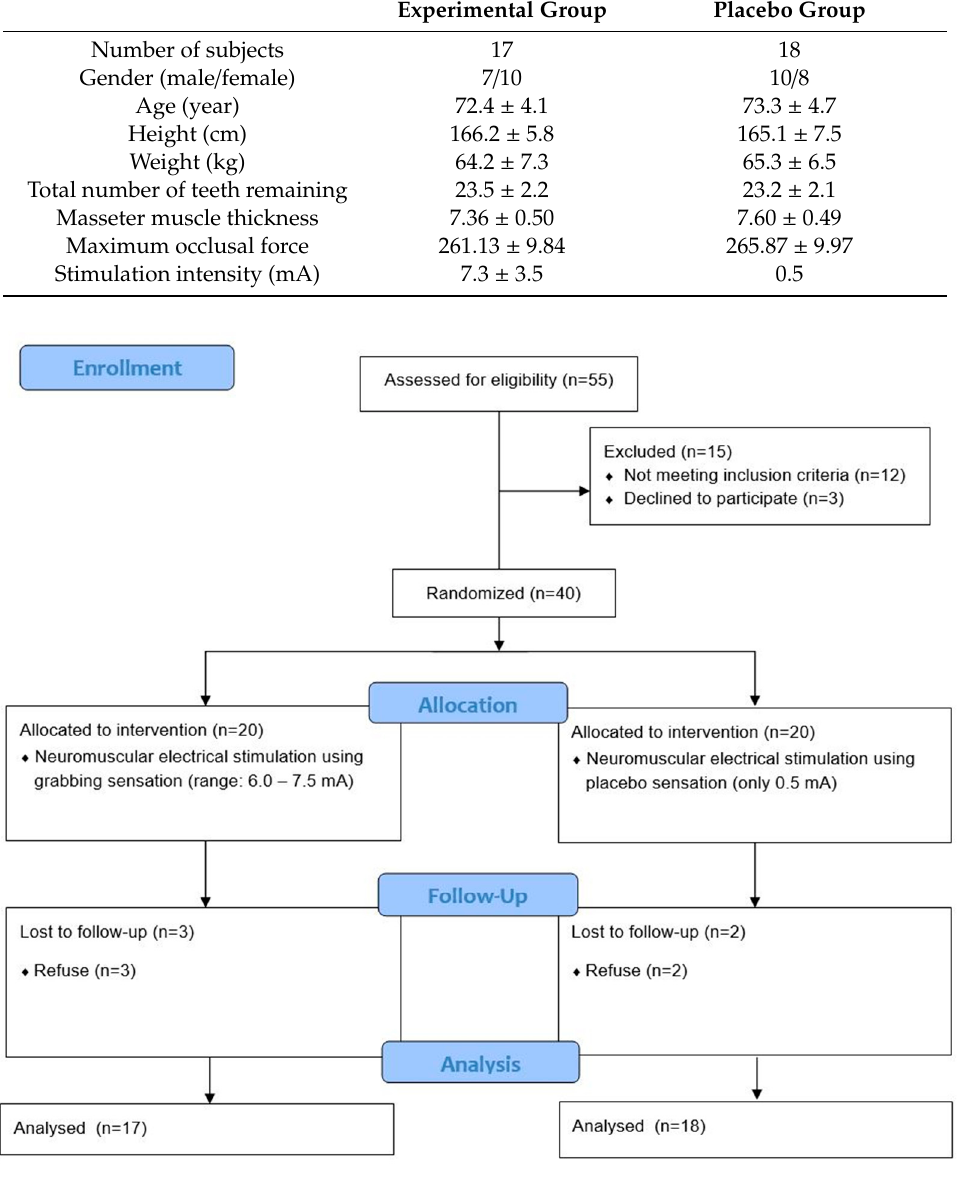
Figure 5. Flow chart of the trial.